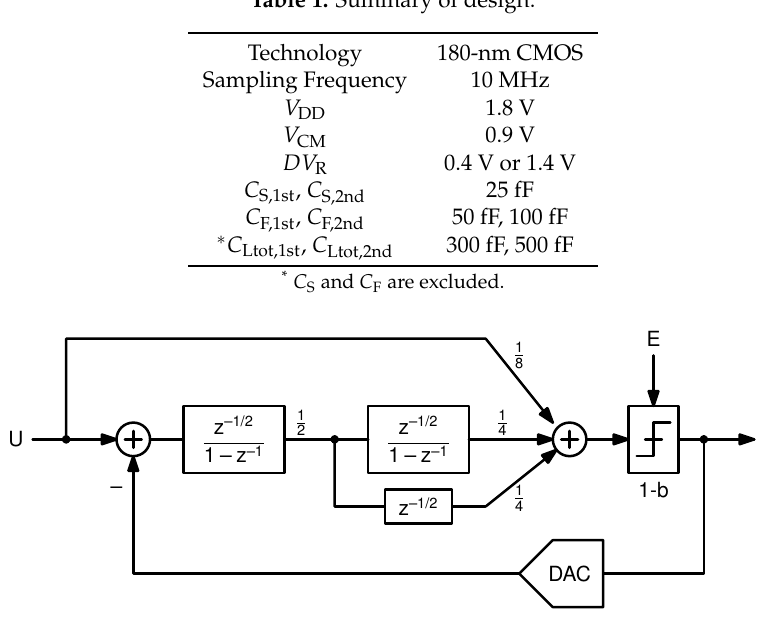
Figure 6. The structure of the designed second-order ∆Σ